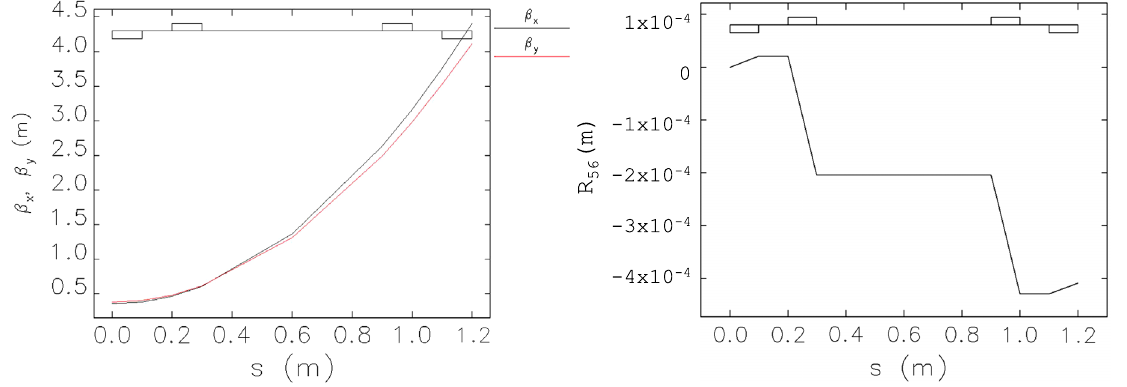
FIG. 7. Betatron functions (left) and R 56 transport matrix term (right) across NIEM at 286 MeV.